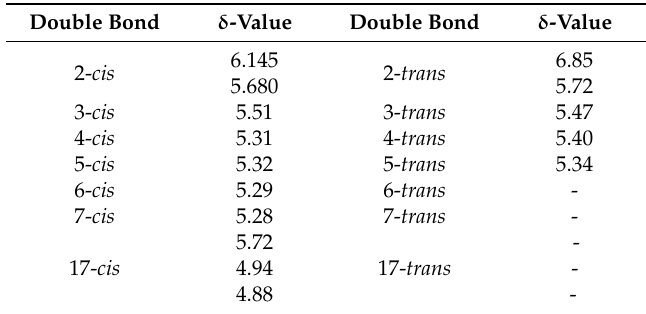
Table 3. 1 H-NMR chemical shifts of alkenyl protons of some methyl octadecenoates in CCl 4 . Reprinted, with permission, from [54]. Copyright 1975, North-Holland Publishing Company.